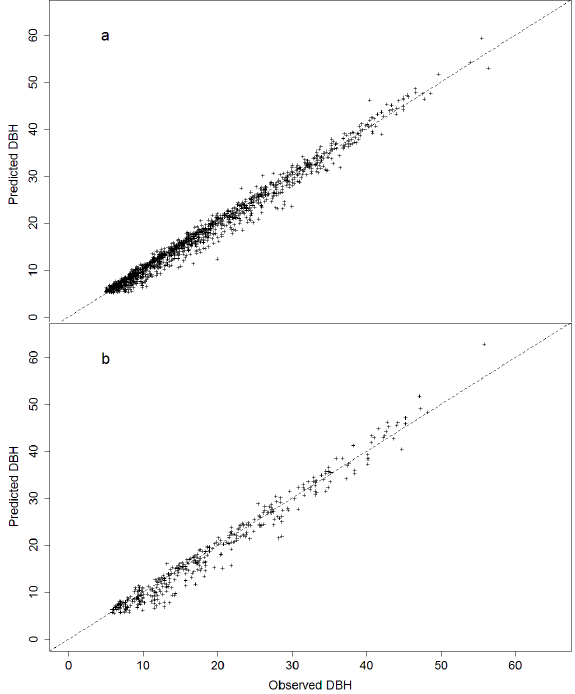
Figure 5. Projection for diameter at breast height (cm) using a period of 6 years (2000 to 2006) ( a ) and 12 years (2000 to 2012) ( b ), using the projection database for the CV + SpZone (cross validation with species-zone factor) model. For further details and goodness-of-fit statistics see Table 5.